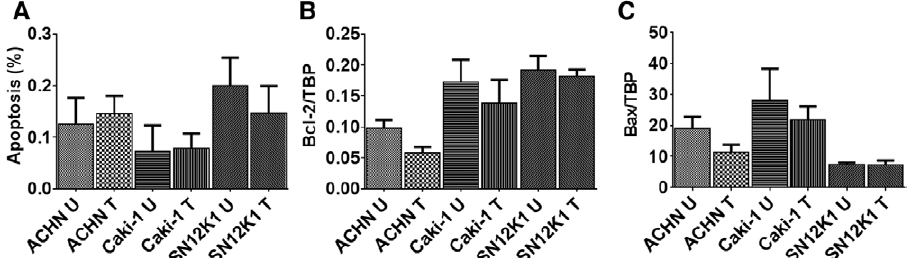
Figure 1. Lack of effect of maslinic acid on apoptosis and apoptosis-regulatory molecules. The effect of maslinic acid on apoptosis of RCC was studied 24 hours after incubating the cells with maslinic acid. Morphologically, maslinic acid did not induce any significant changes in apoptosis (A). These results were further confirmed at the molecular level by the lack of significant changes in the expression of the antiapoptotic molecule Bcl-2 (B), and the proapoptotic molecule Bax (C). U: untreated; T: treated with maslinic acid.